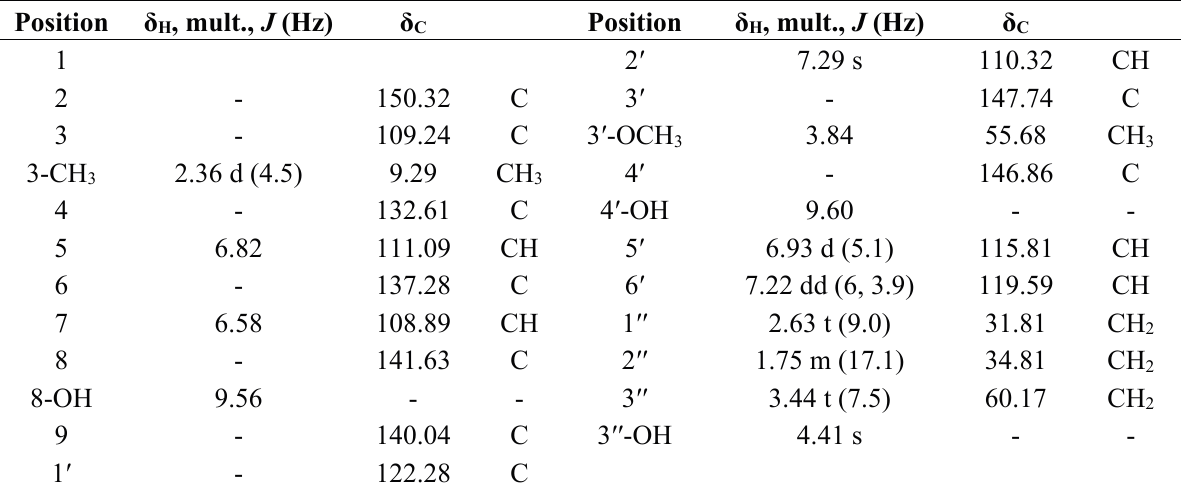
Table 5. 1 H- and 13 C-NMR data of peak 12.